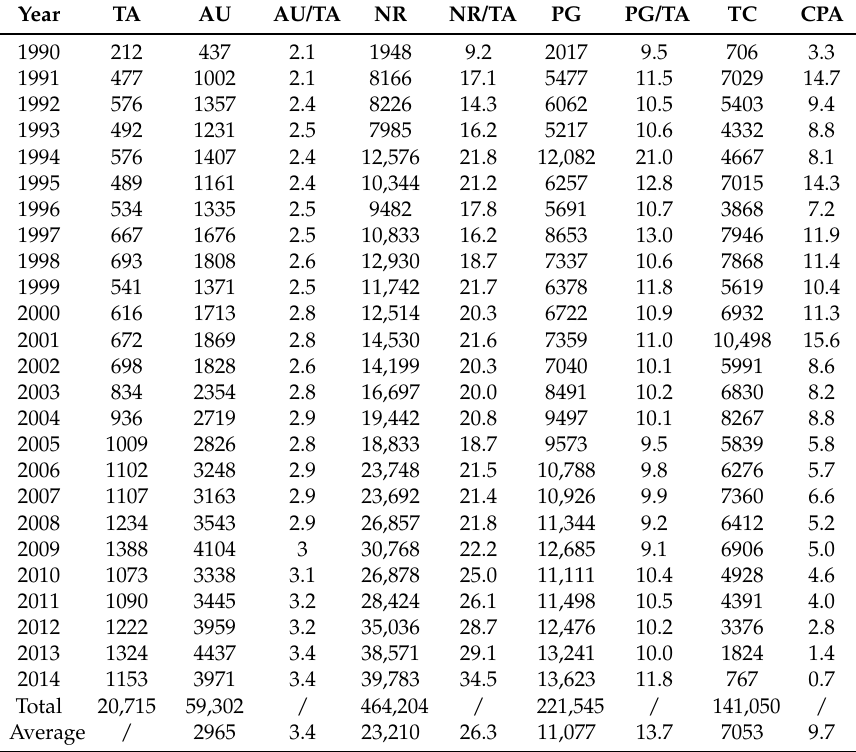
Table 1. Summary scientific outputs from 1990–2014.